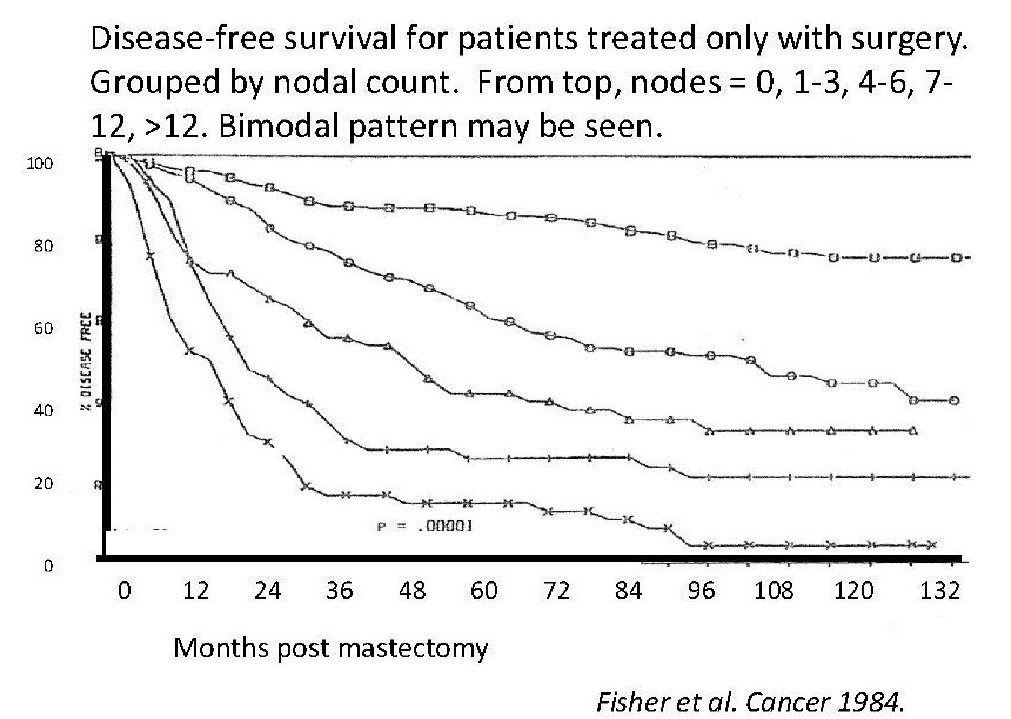
Figure 3. Disease-free-survival reported (modified) from Fisher et al.